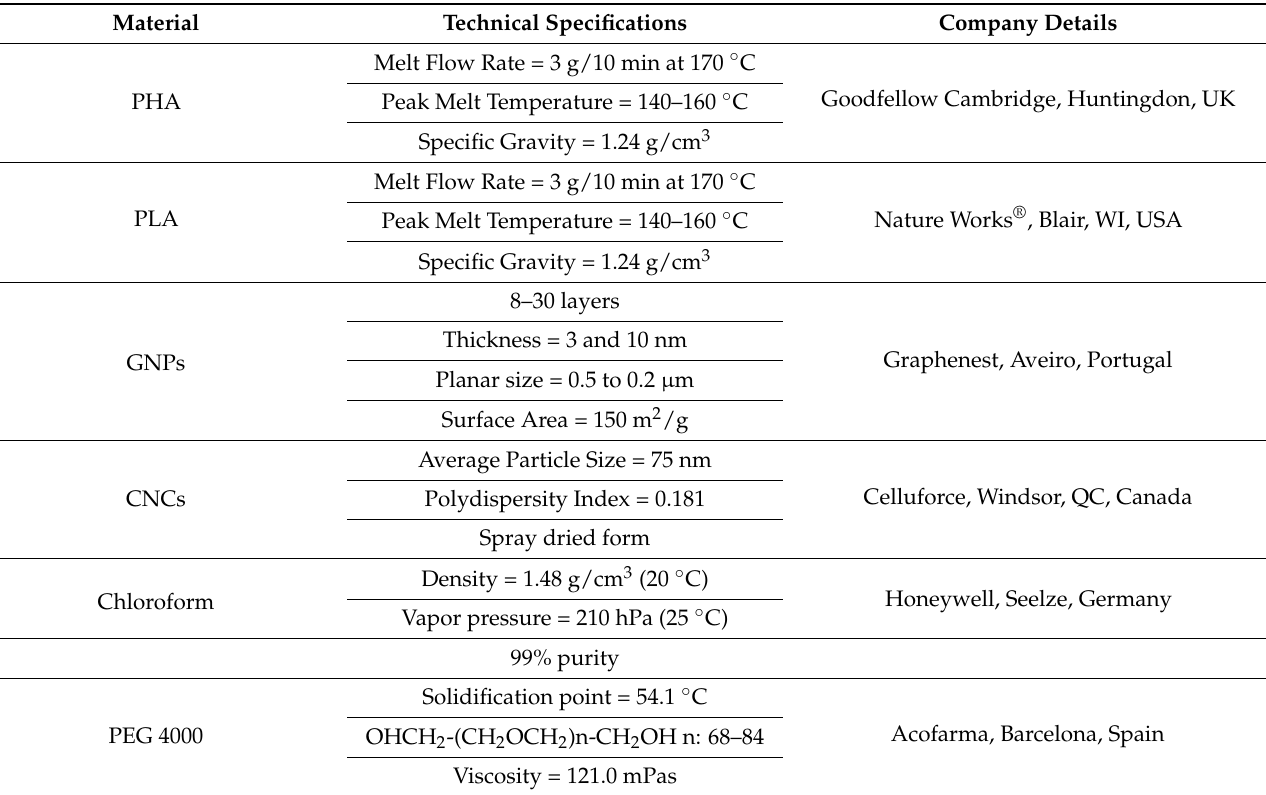
Table 1. Technical Data of the